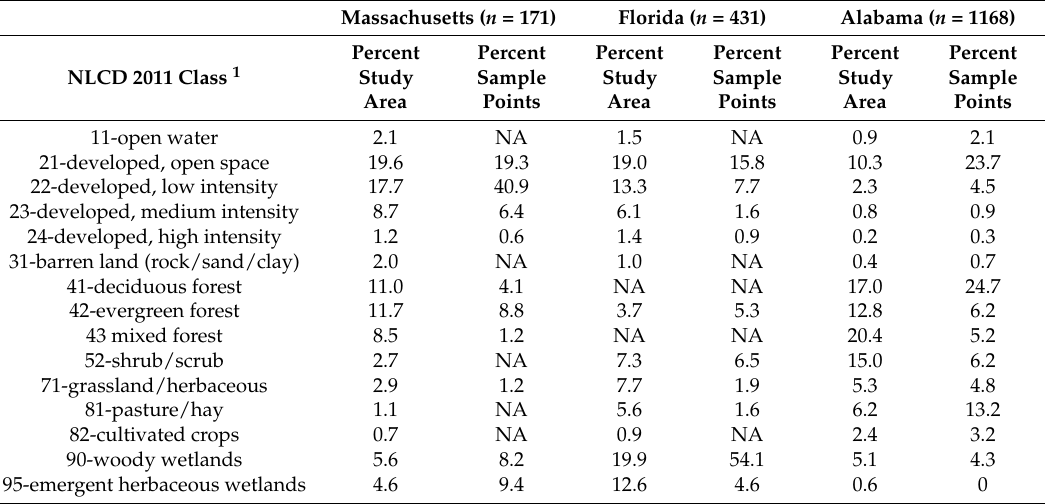
Table 2. NLCD 2011 1 class representation in raccoon risk model study area and sample point data (5 January 2012–26 June 2014) from within pine-dominated landscapes of Massachusetts, Florida, and